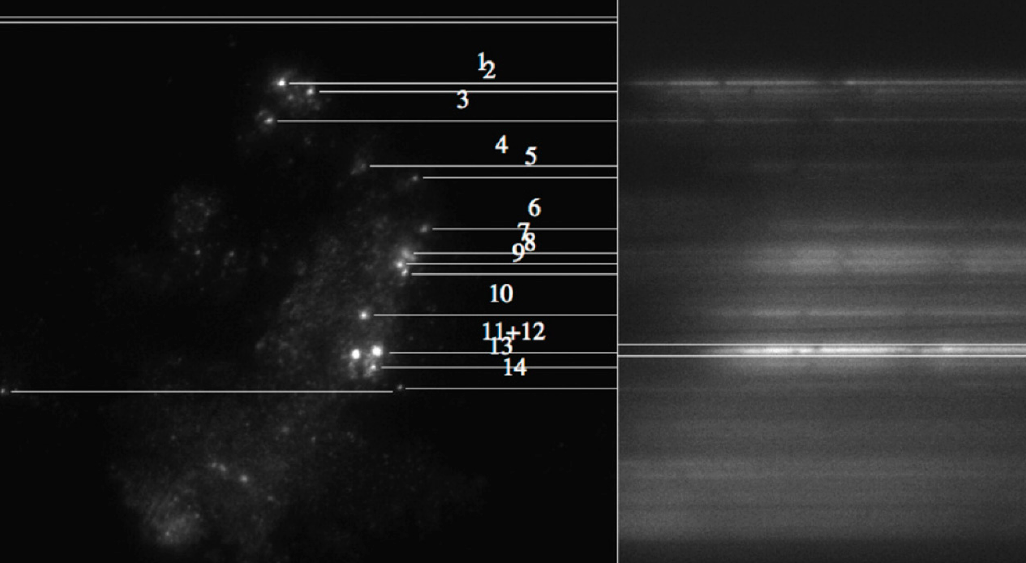
Figure 7. Left: an STIS UV image of the star-forming region near the center of M83. Many UV-bright star clusters can be seen. Compare with Figure 5, which shows individual stars . The field size is approximately 280 pc × 280 pc. Right: the corresponding spectra of the clusters obtained by using slitless spectroscopy in the region with STIS . From [24].